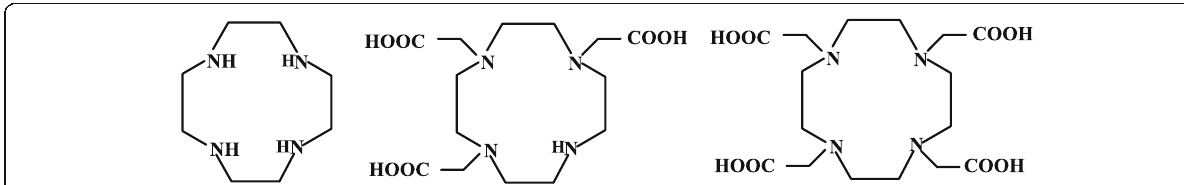
Fig. 1 Chemical structures of (left) cyclen (1,4,7,10-tetraazacyclododecane); (middle) DO3A (1,4,7,10-tetraazacyclododecane-1,4,7-triacetic acid); (right) DOTA (1,4,7,10-tetraazacyclododecane- N , N ′ , N ′′ , N ′′′ -tetraacetic